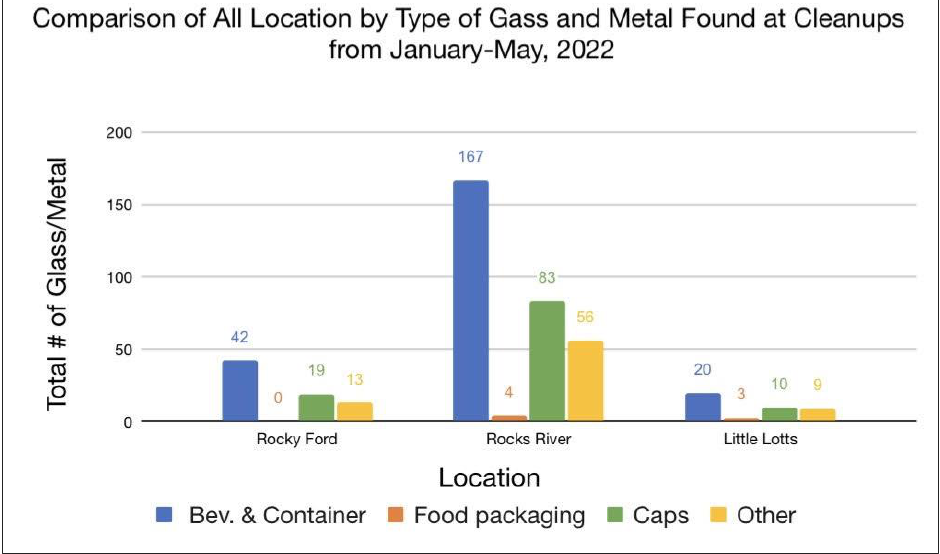
Figure 15. Trash Analysis — Glass and Metal Products Found During Cleanups.